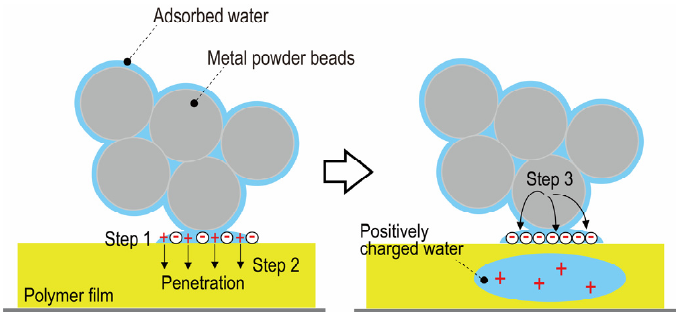
Figure 1. Charged-water penetration (CWP) model for the triboelectric charging of polymer films.